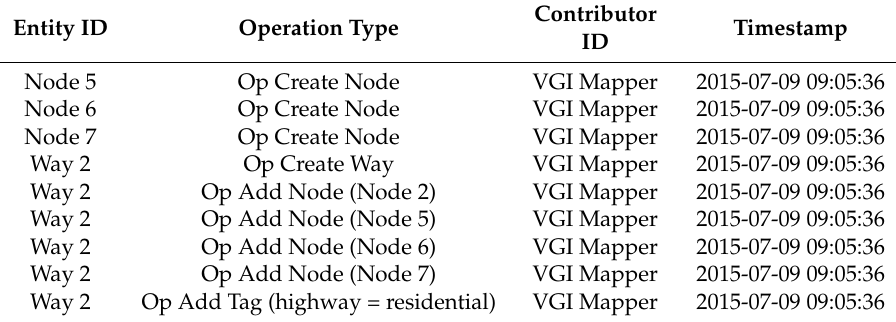
Table 5. Operation sequence of a single mapping action (creating a street). Figure 3. A new residential street (red) being created and connected to an existing one (black).